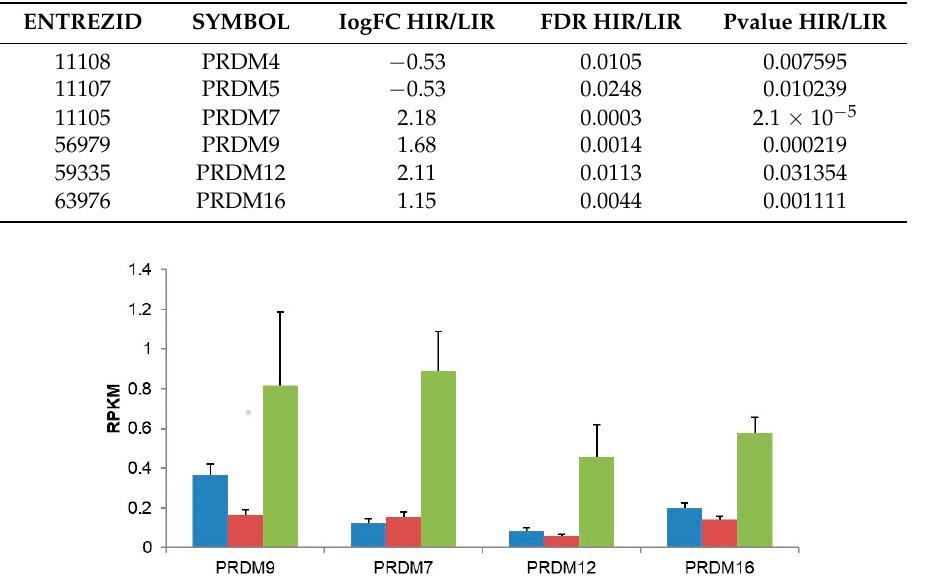
Figure 1. Increases in PRDM gene expression following GnRHa treatment. Results are presented as reads per kilobase and per million (RPKM), and the median and median absolute deviation (MAD) values are presented. Blue bars represent low infertility risk (LIR) untreated testes, red bars represent high infertility risk (HIR) testes before treatment, and green bars represent HIR testes after GnRHa treatment.